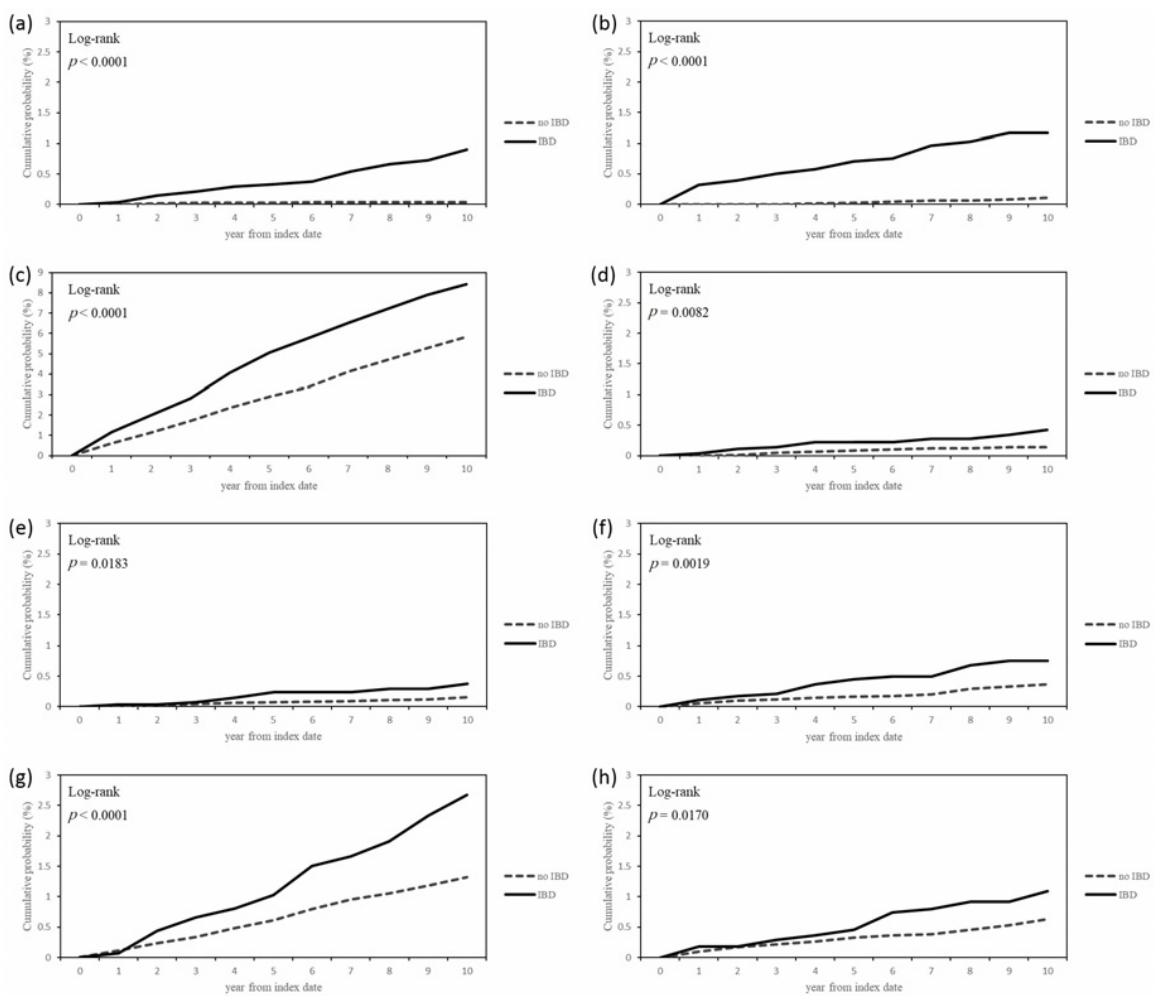
Figure 2. Cumulative probabilities of dermatologic diseases after index date: ( a ) pyoderma gangrenosum, ( b ) erythema nodosum, ( c ) aphthous stomatitis, ( d ) polyarteritis nodosa, ( e ) hidradenitis suppurativa, ( f ) psoriasis, ( g ) rosacea, and ( h ) atopic